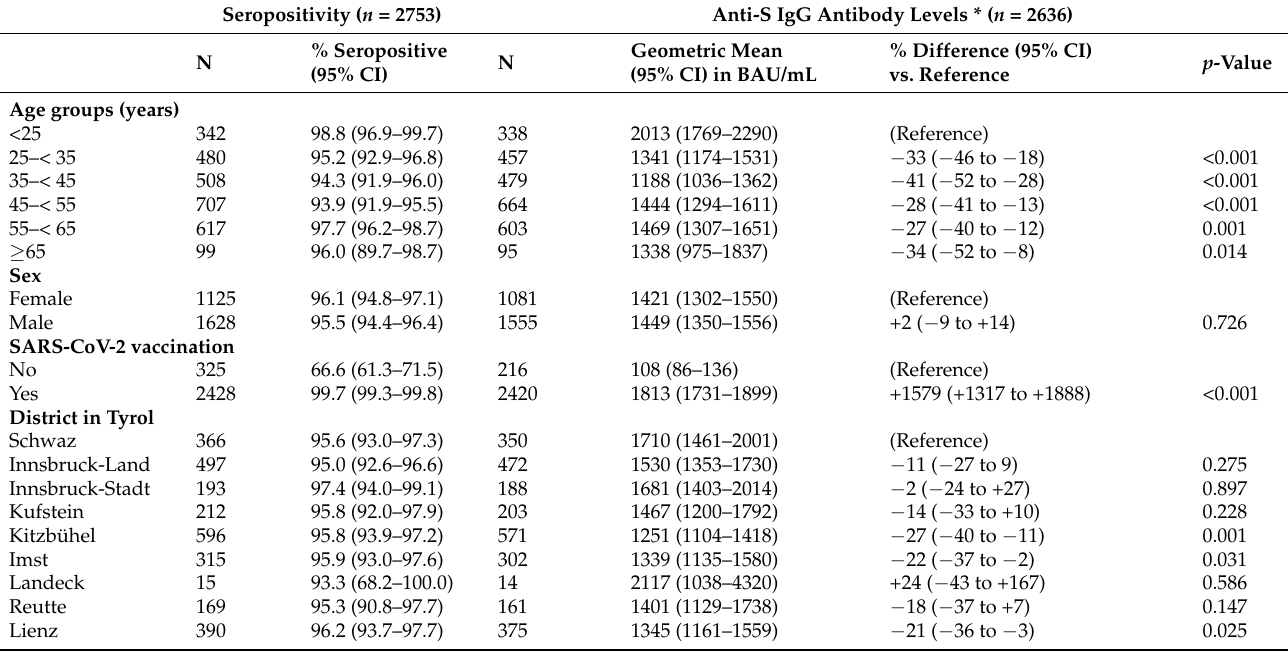
Table 3. Cross-sectional correlates of seroprevalence and anti-S IgG antibody levels; Tyrol, Austria; April